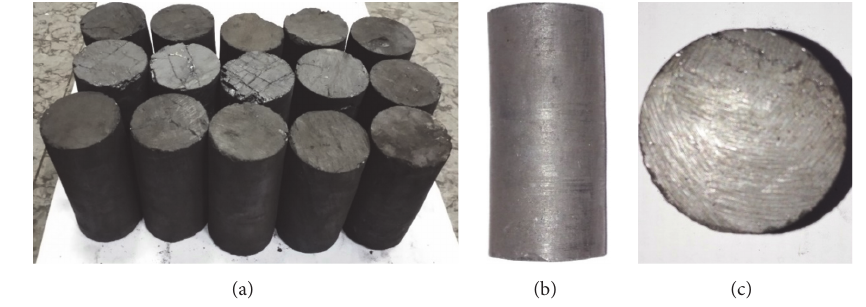
Figure 2: The physical figures of coal samples.